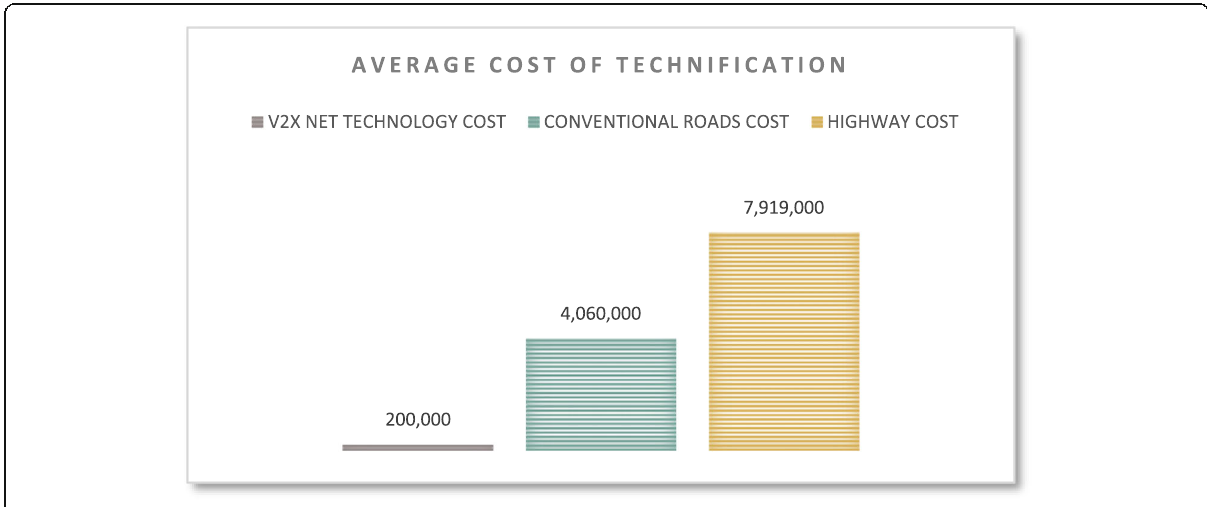
Fig. 22 The average cost of technification a road in